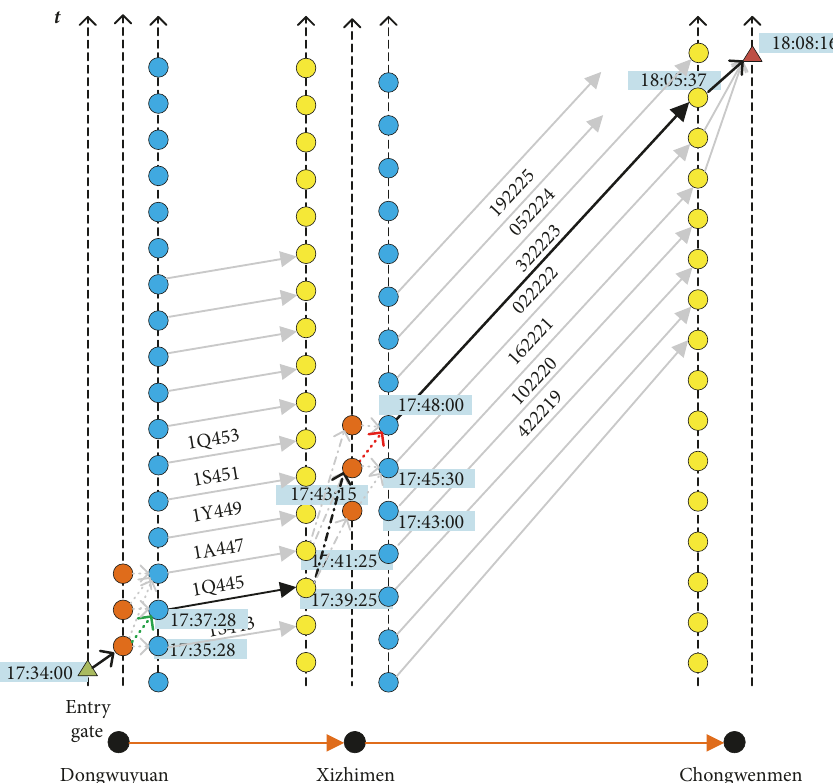
Figure 7: Space-time-sequence trajectory-estimation